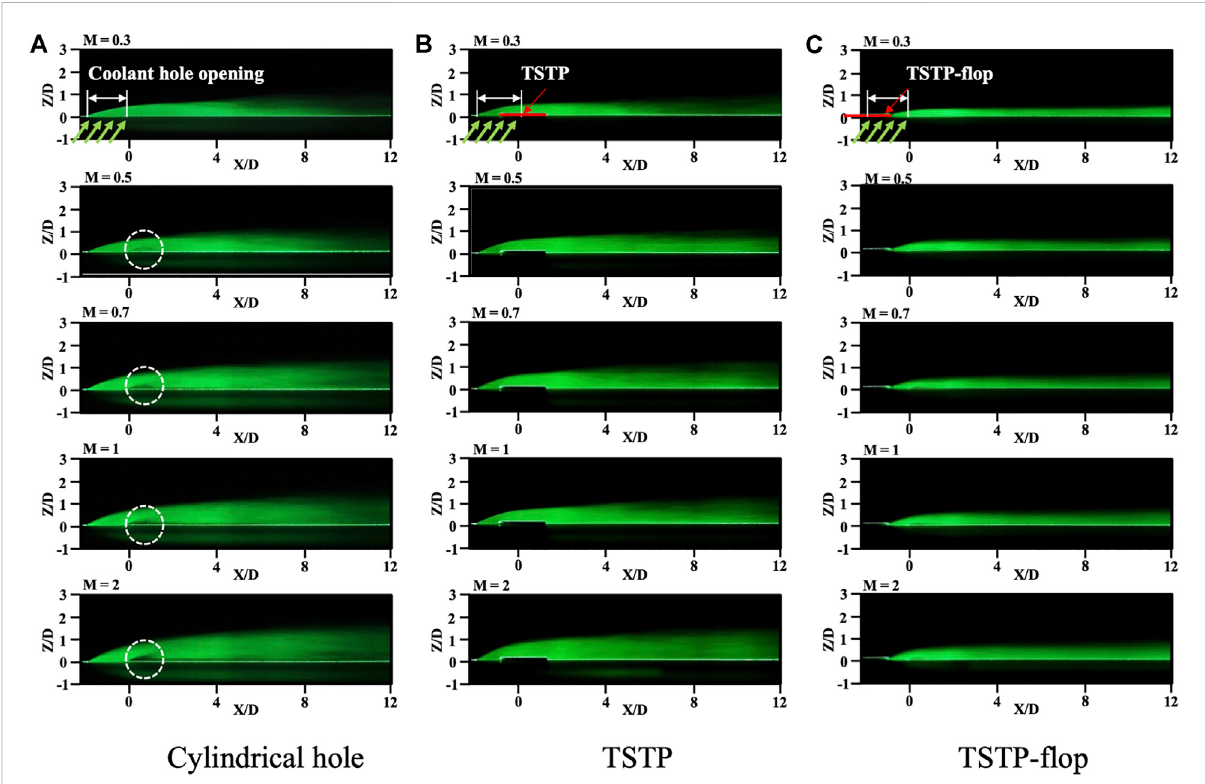
FIGURE 5 Flow fi eld visualization with varying blowing ratios for 0.3 to 2.0 in the center plane of the X-Z coordinate. Three columns represent cylindrical hole, TSTP, and TSTP- fl op,